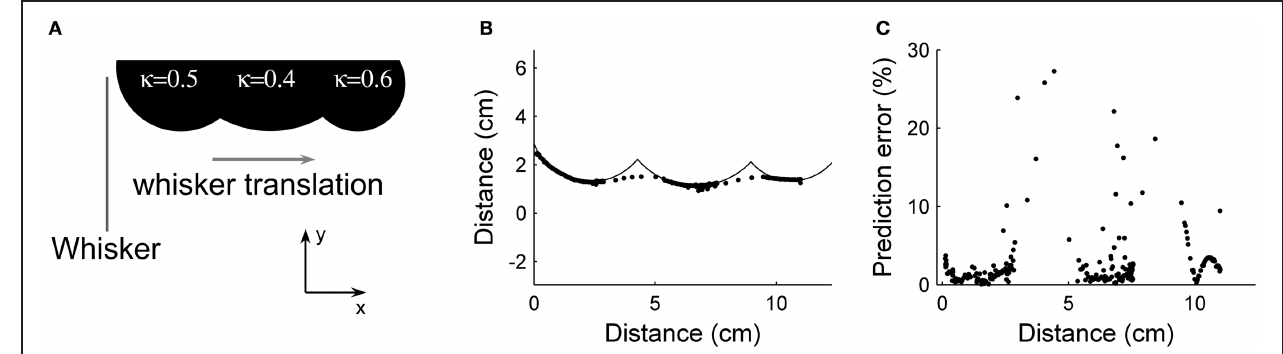
FIGURE 11 | Prediction of future contact points demonstrated in hardware using an object with abruptly changing curvatures. (A) Test object, consisting of three circles placed in a row. The curvature of each circle is indicated; the curvatures at which the circles join is very high and was not